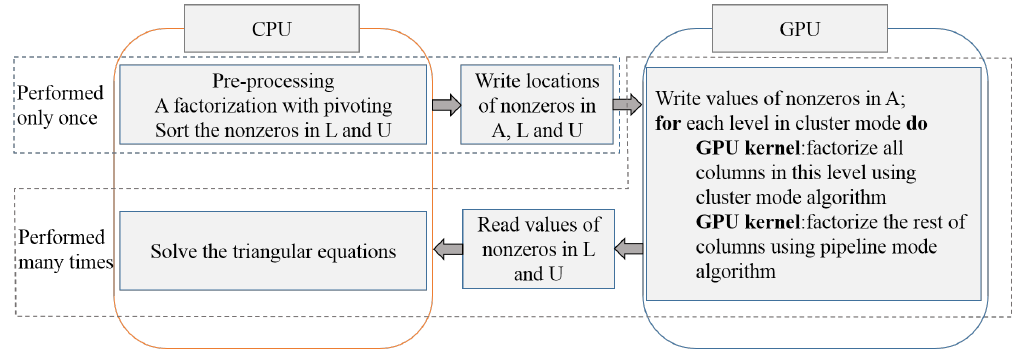
Figure 3. Framework of the sparse solver in